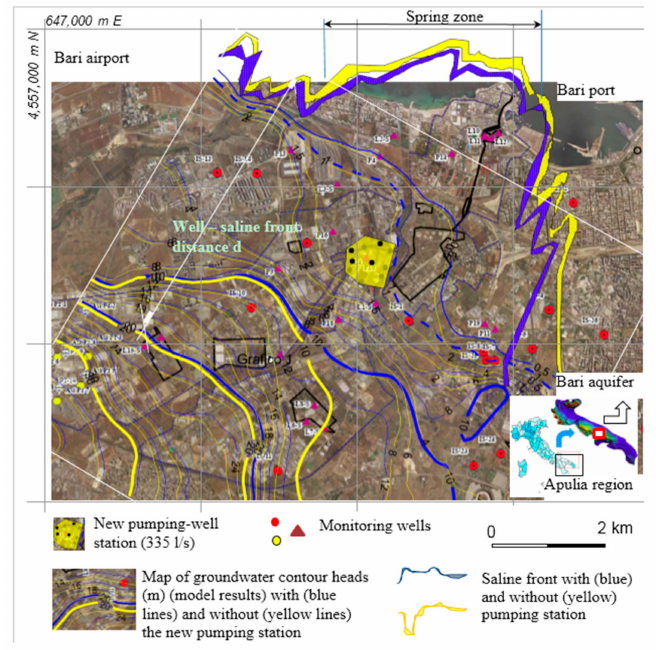
Figure 3. Spatial distribution of wells (red circles and tringles) and flow simulation results with distance d of each well from position of Ghyben-Herzberg saline front in groundwater. The yellow lines (and polygon) refer to actual groundwater flow simulation. The blue lines (and polygon) consider the flow modifications due to new pumping of 335 L ¨ s ´ 1 . The blue dashed line is the contour head at 1